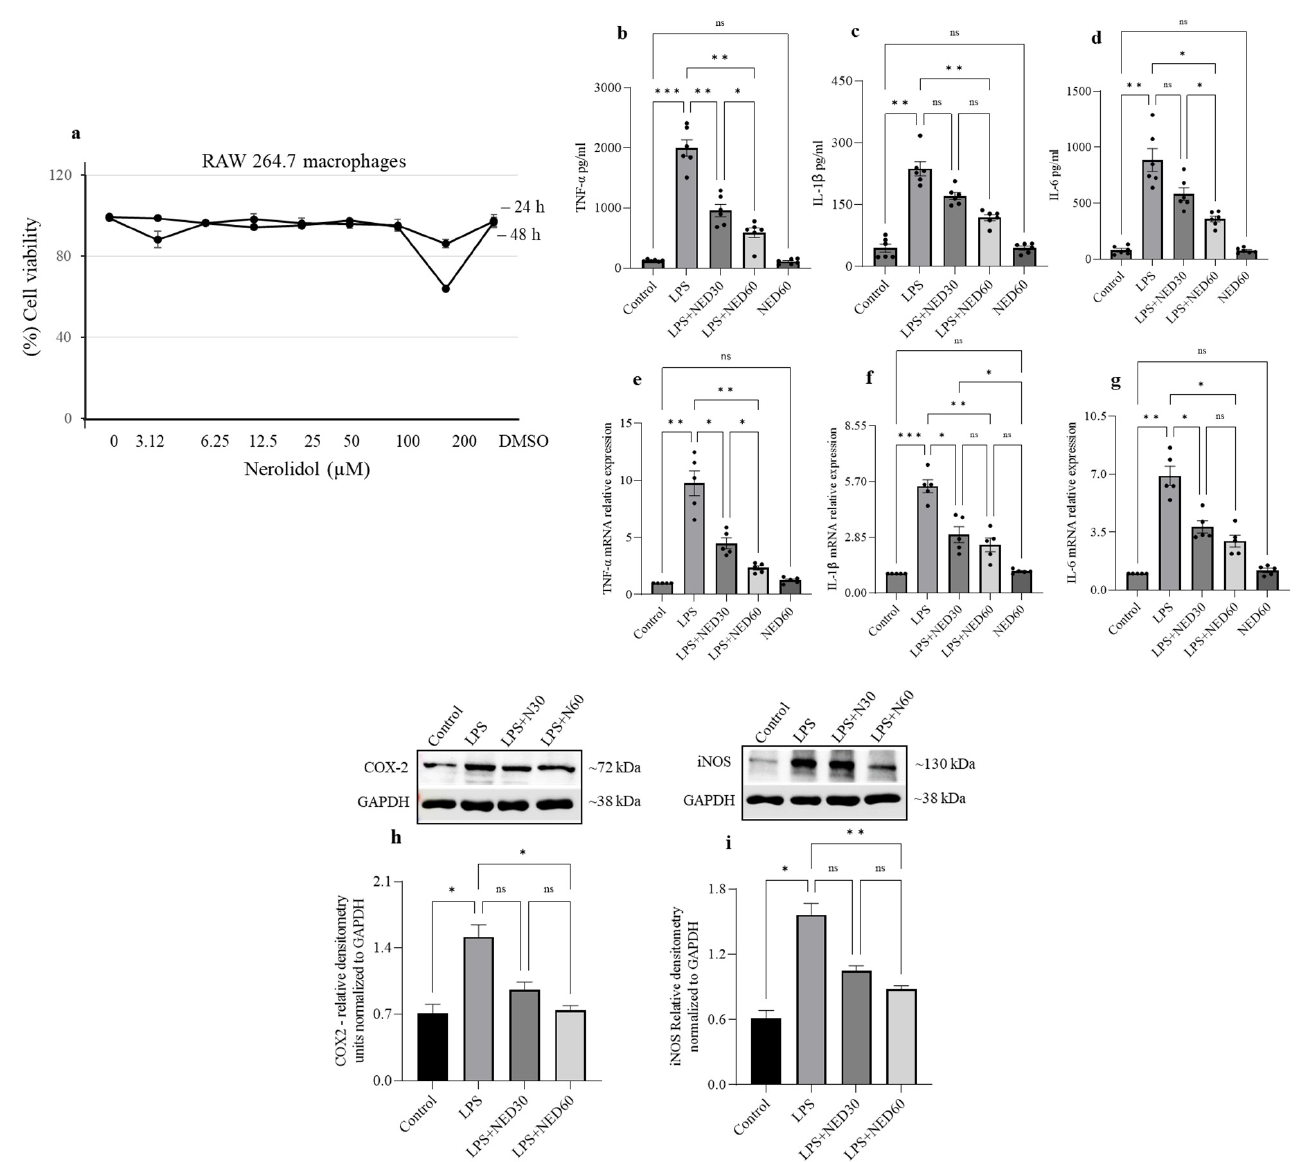
Figure 2. Effect of NED on cell viability and proinflammatory cytokines and COX-2 and iNOS protein expression in LPS-stimulated RAW 264.7 macrophages. ( a ) Cell viability was determined through treatment with various concentrations of NED. LPS-stimulated macrophages showed a significant increase in the release of proinflammatory cytokine protein ( b – d ) and mRNA expression ( e – g ) of TNF- α , IL-1 β , and IL-6. NED pre-treatment significantly prevented this. ( h , i ) LPS stimulation significantly increased COX-2 ( h ) and iNOS ( i ) protein expression. NED treatment prevented the further rise of COX-2 and iNOS protein expression induced by LPS. Data were obtained from n = 5 separate cell culture samples for ELISA and mRNA expression. Densitometry values are expressed as means ± SEM (n = 3). The results are expressed as mean ± SEM. * p ≤ 0.05, ** p ≤ 0.01, and *** p ≤ 0.001 and ns indicates not signi fi cant.